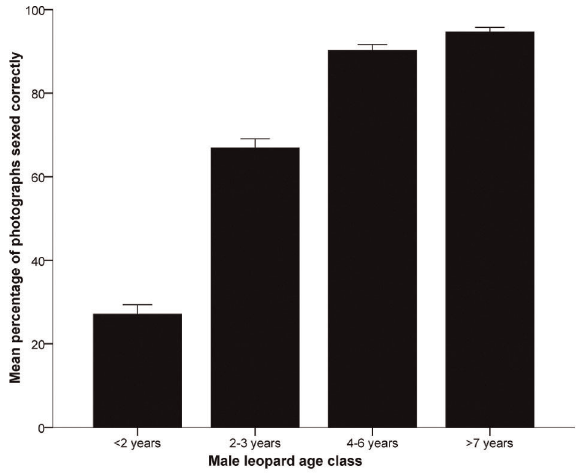
Figure 2. Mean percentage of male leopard photographs in different age classes sexed correctly by survey respondents. Bars show standard error (n = 225).